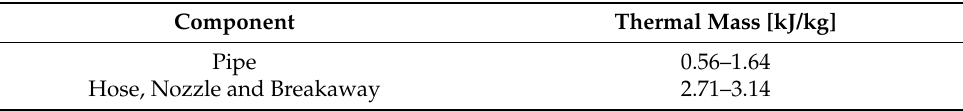
Table 4. Thermal Mass of several components in the dispensing line. Data retrieved from